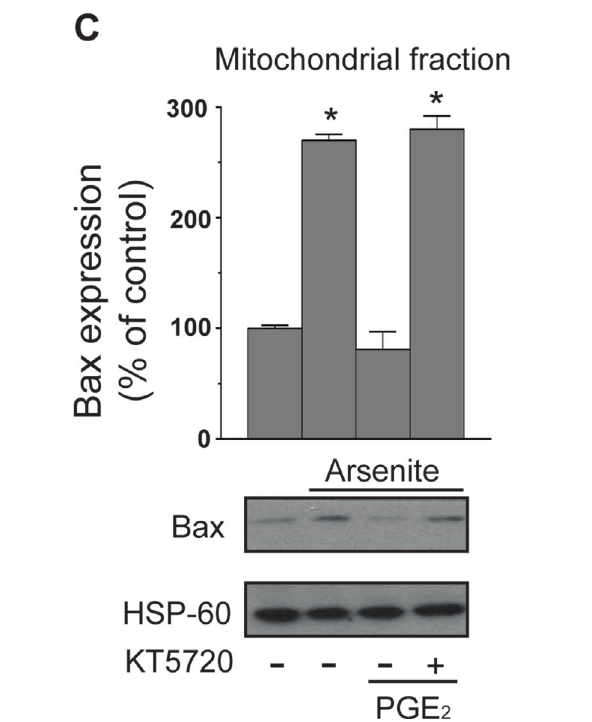
FIGURE 3 | PGE 2 prevents the mitochondrial translocation of Bad and Bax induced by arsenite. Cells received the treatments indicated in the figure prior to the addition of arsenite. After 16 h, the cells were processed to obtain the mitochondrial fraction for Western blot analysis using anti-Bad (A) and anti- Bax (C) antibodies. In other experiments, the cells were treated as indicated above and lysed prior to Western blot analysis using an antibody recognizing Bad phosphorylated at Ser 112 (B) . Blots shown are also probed for actin, or HSP-60, and are representative of three separate experiments with similar outcomes. * p < 0.01, as compared with untreated cells (one-way ANOVA followed by Dunnett’s